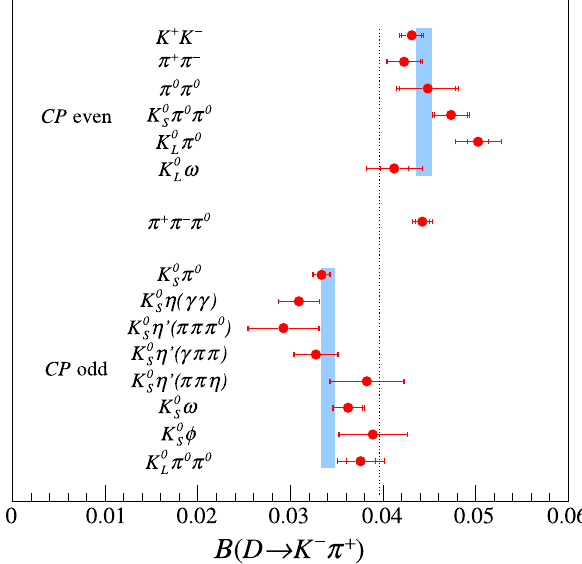
Fig. 4 Branching fractions of D − → K − π + , D X → K − π + and D + → K − π + determined with different tag modes. The outer error bars show the full uncertainty and the inner error bars the statistical uncertainty. The blue bands indicate the averaged result over each set of tags, and the vertical dotted line shows the measured central value of the D 0 → K − π + branching fraction [21]